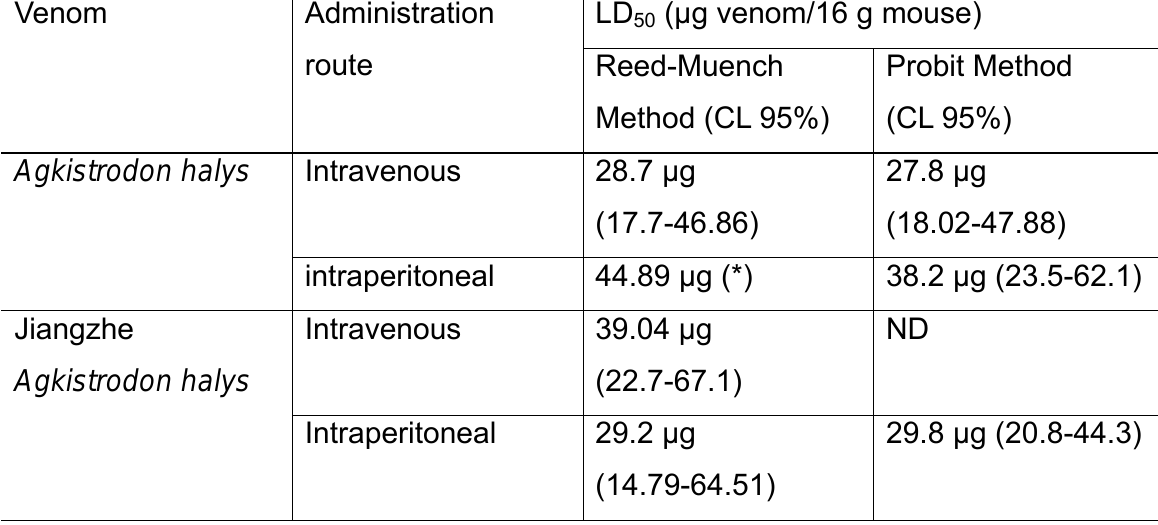
Table 1: Determination of the median lethal dose (LD intraperitoneally injected into